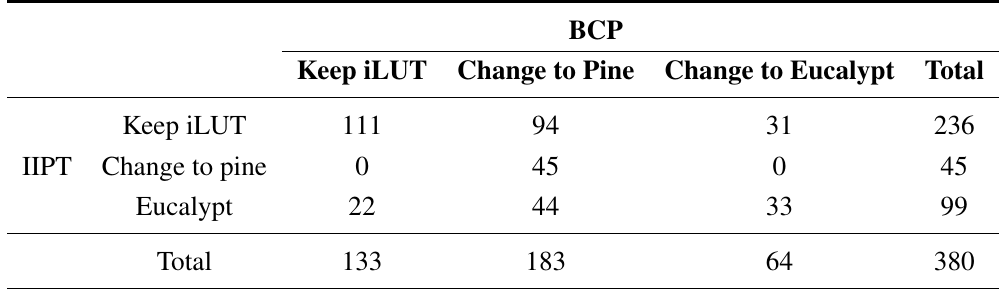
Table 7. Confusion matrix contrasting the output of Iterative Ideal Point Thresholding (IIPT) and Compromise Programming (CP). Overall agreement =